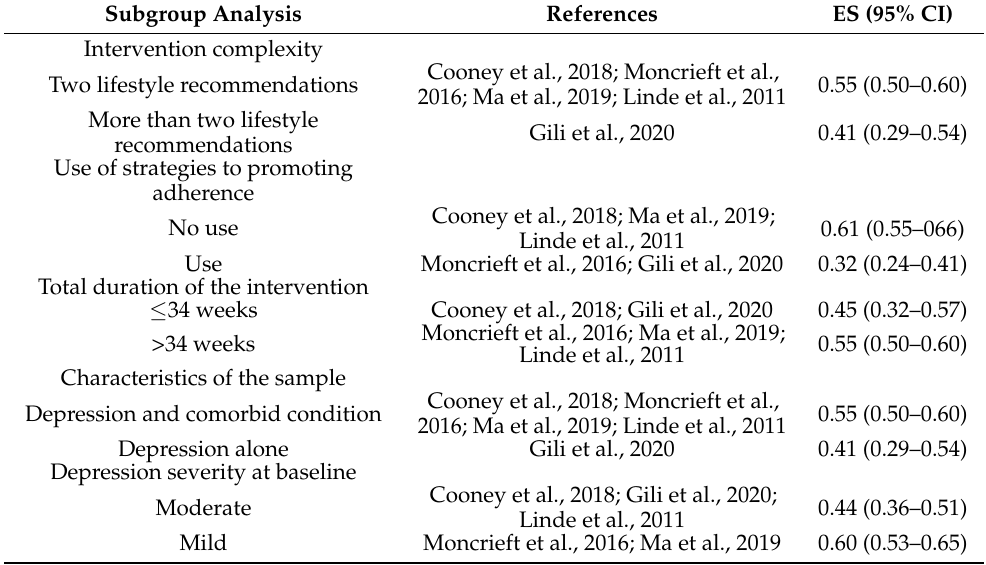
Table 3. Subgroup meta-analysis of the adherence of healthy lifestyle interventions for adults with depression.